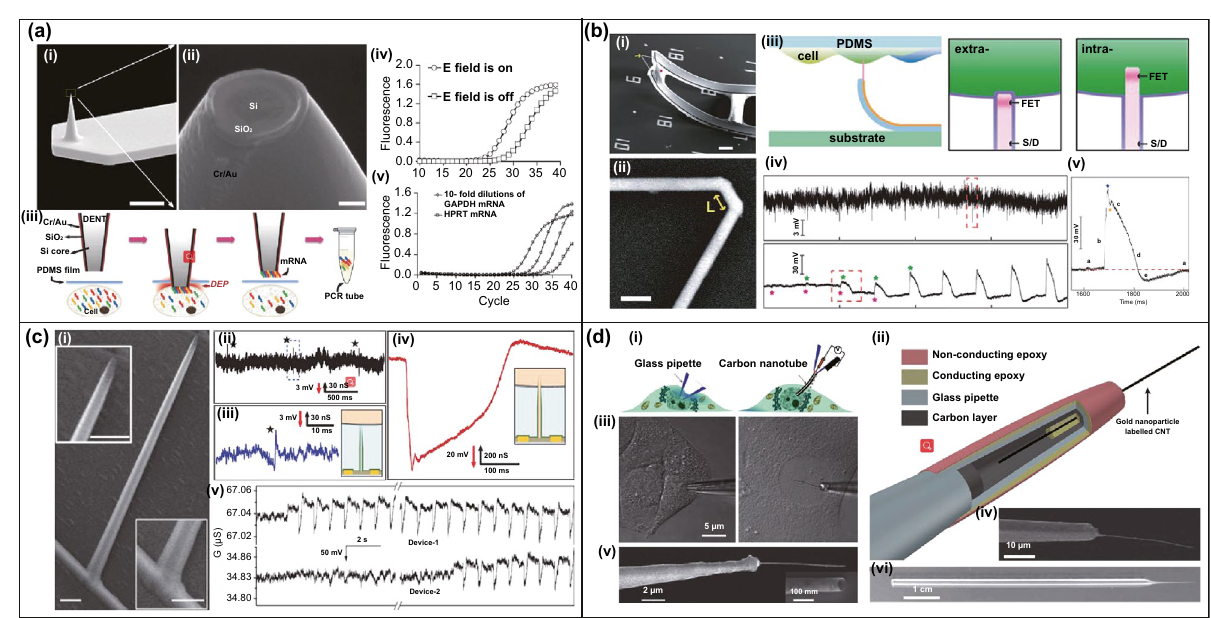
Fig. 1 a (i, ii) SEM images of the coaxial AFM probe. (iii) The operation of single‑cell mRNA extracted using DENT. (iv) Figure indicates field on and field off for β‑actin mRNA. (v) Detection of GAPDH and HPRT [71–73]. b (i, ii) SEM images of an as‑made device and a doubly kinked nanowire with a cis configuration. (iii) Diagram of recording from the monolayer of cardiomyocyte. (iv) Extracellular and intracellular electrical recording from beating cardiomyocytes. (v) Steady‑state intracellular recording [74]. c (i) SEM image of a nanotube on a silicon nanowire. (ii–iii) Representative trace reflecting the extracellular recording. (iv) Magnified view of the peak in the intracellular recording. (v) Simultaneously recording extracellular and intracellular electrical signals from the two devices [75]. d (i, ii) Comparison of cellular endoscopes with glass pipettes. (iii) HeLa cell (left) was interrogated by a glass pipette, and a primary rat hepatocyte nucleus was interrogated by a nanotube endoscope. (iv, v) SEM image of endoscopes fitted with 100 and 50 nm carbon nanotube tips, respectively. (vi) Optical image of a glass pipette with a carbon‑nanotube tip [59]. Reproduced with permission from Refs. [59, 71–75], copyright (2010) Nature Publishing Group (2017) Applied Physics Letters Publishing Group (2017) The Royal Society of Chemistry Publishing Group (2009) Applied Physics Letters Publishing